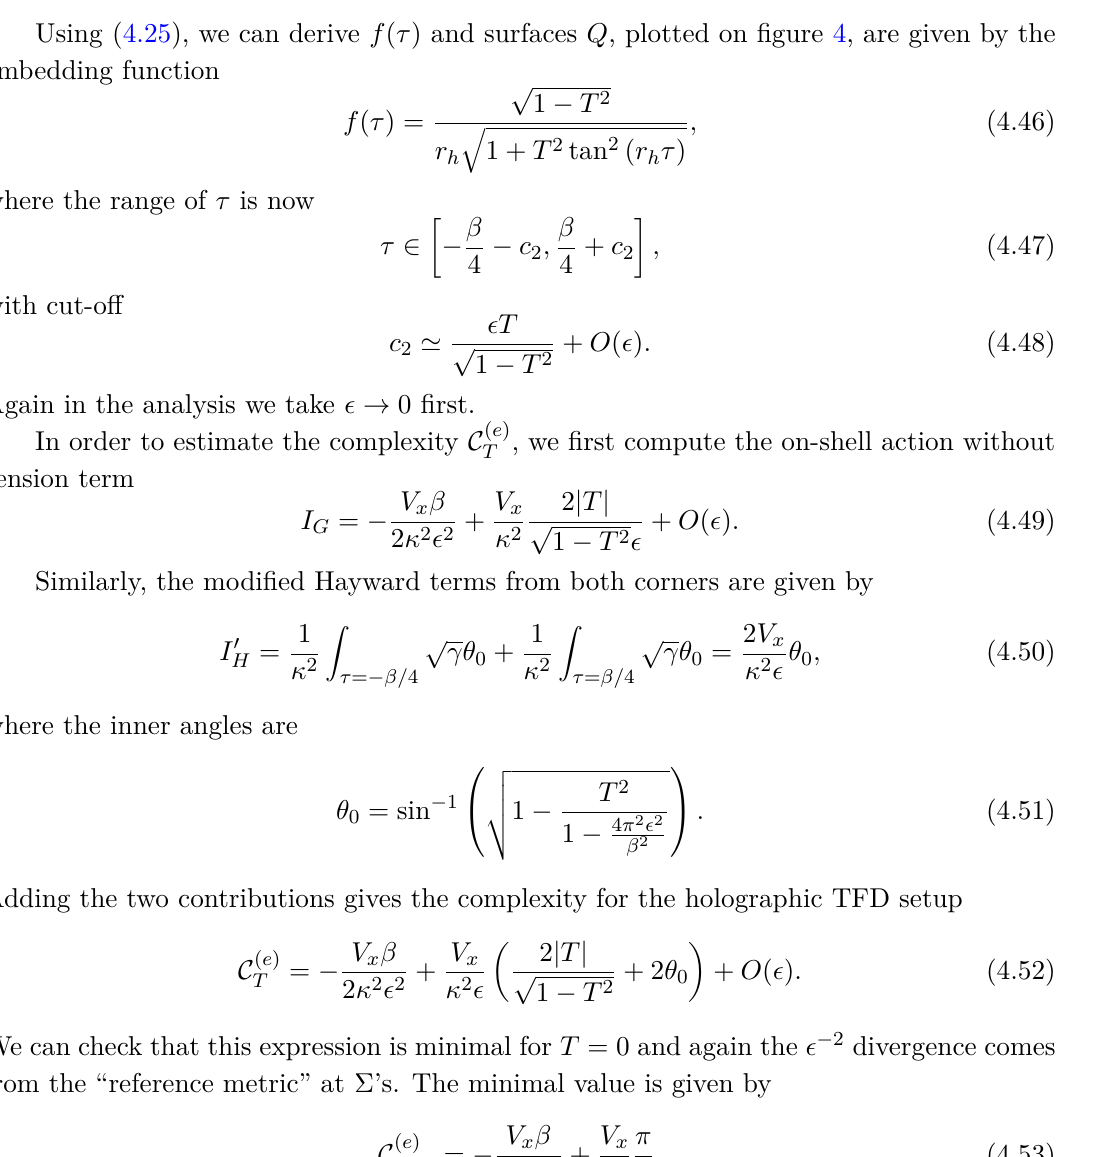
Figure 4 . Solutions (4.46) shown on the cigar geometry (left) and its projection (right) for a few sample values of T interpolating between T = 0 (red) and T = − 1 (green). The semi-circles have the range τ ∈ [ − β/ 4 , β/ 4]